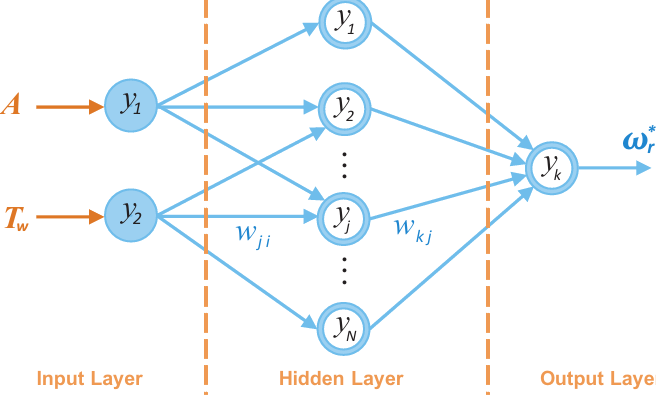
Figure 8. Proposed Multi-Layer Perceptron structure.